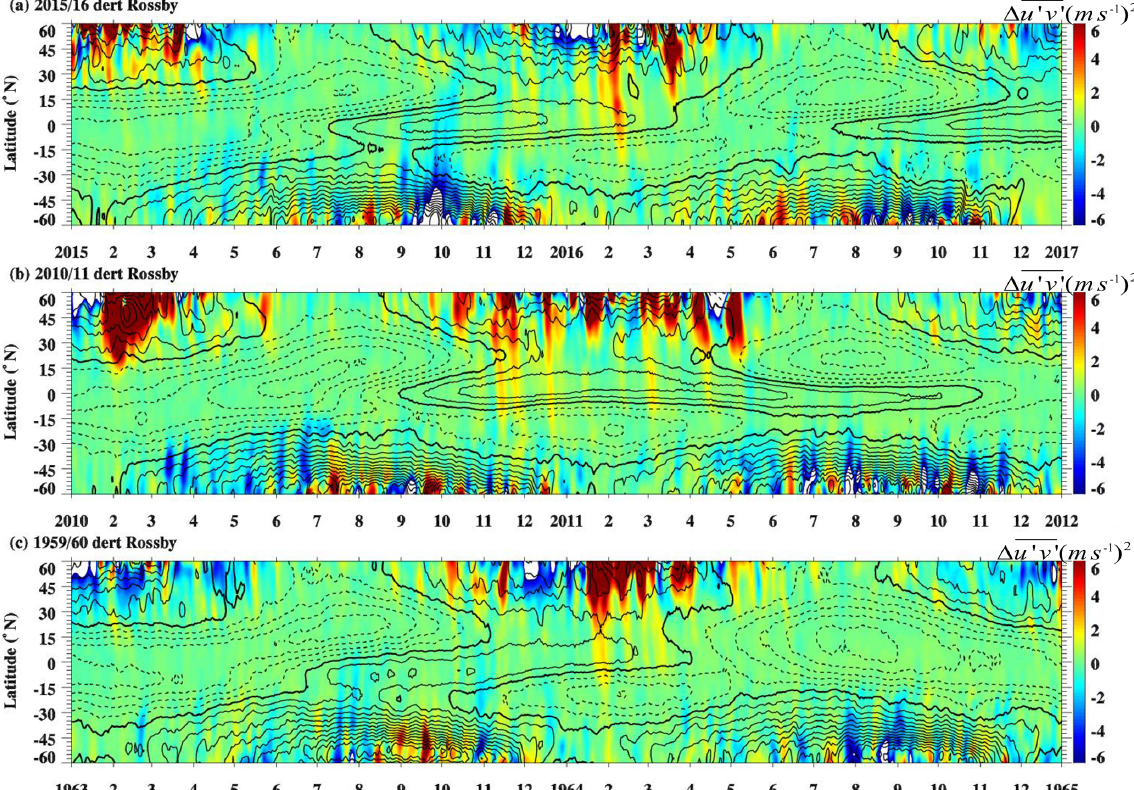
Figure 3. Temporal evolution of meridional propagation of westward-propagating Rossby waves (with period of 5–70d) horizontal momen- tum flux anomaly in (a) 2015/2016, (b) 2010/2011, and (c) 1959/1960 at 40hPa. Color shadings denote the anomalies with respect to the monthly climatology (unit is m 2 s − 2 ). The zonal mean zonal wind is overlaid in black contours with contour interval of 5ms − 1 . The solid and dotted black contours denote westerly and easterly winds, respectively. The thick contours represent the zero wind